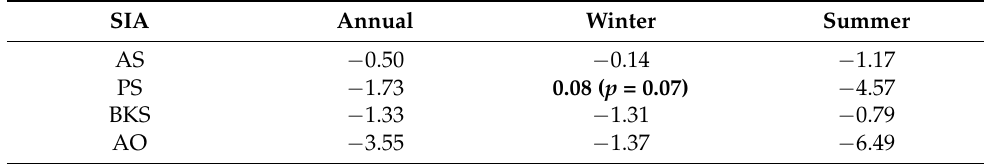
Table 2. The annual and seasonal variability trends of SIA (10 4 km 2 ) in 1979–2020 for the Atlantic sector, Pacific sector, Barents–Kara Seas and the Arctic